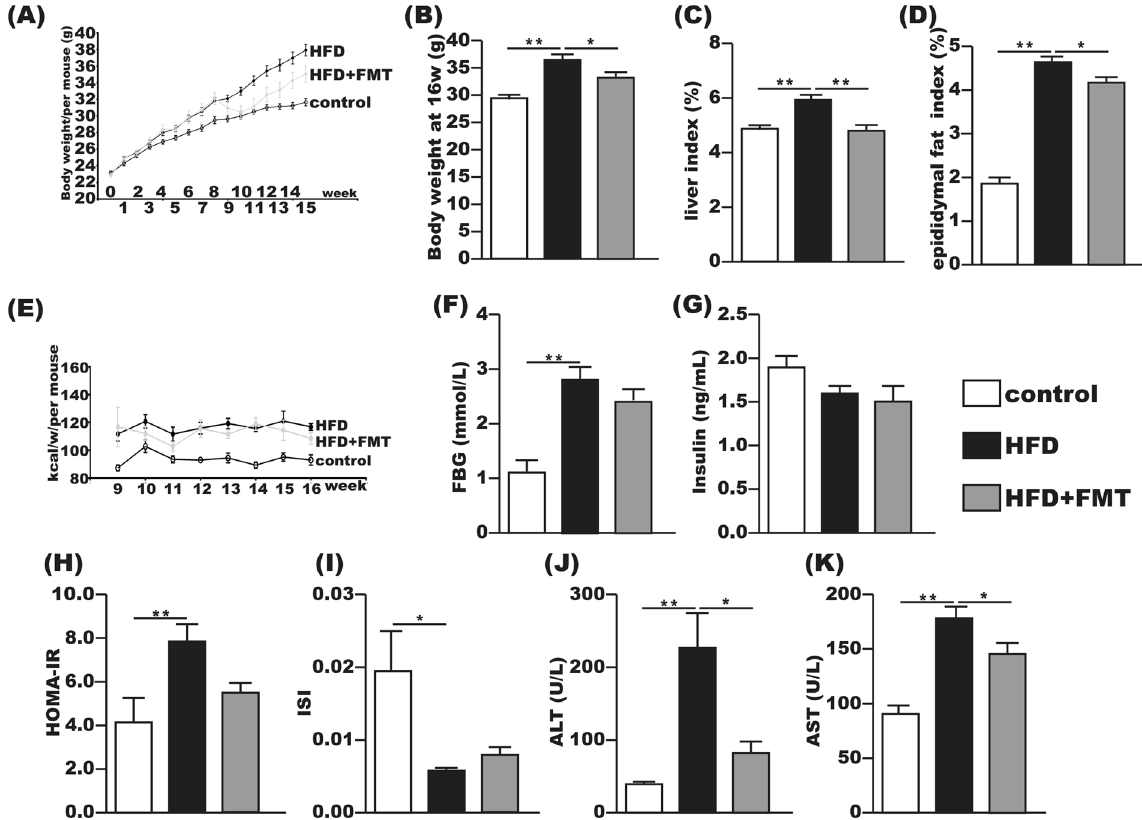
Figure 1. FMT attenuated HFD-induced obesity, liver injury and metabolic disturbance. ( A,B ) Body weight changes and body weight at 16th week. ( C ) Liver index = liver weight/body weight × 100. ( D ) Epididymal fat index = epididymal fat weight/body weight × 100. ( E ) Energy intake per mouse per week. ( F,I ) Fasting serum glucose, fasting serum insulin, HOMA-IR and ISI of the three groups. J,K ) Serum ALT and AST. The data represent the mean ± S.E.M. (n = 12 mice per group), * P < 0.05, ** P < 0.01 and *** P <